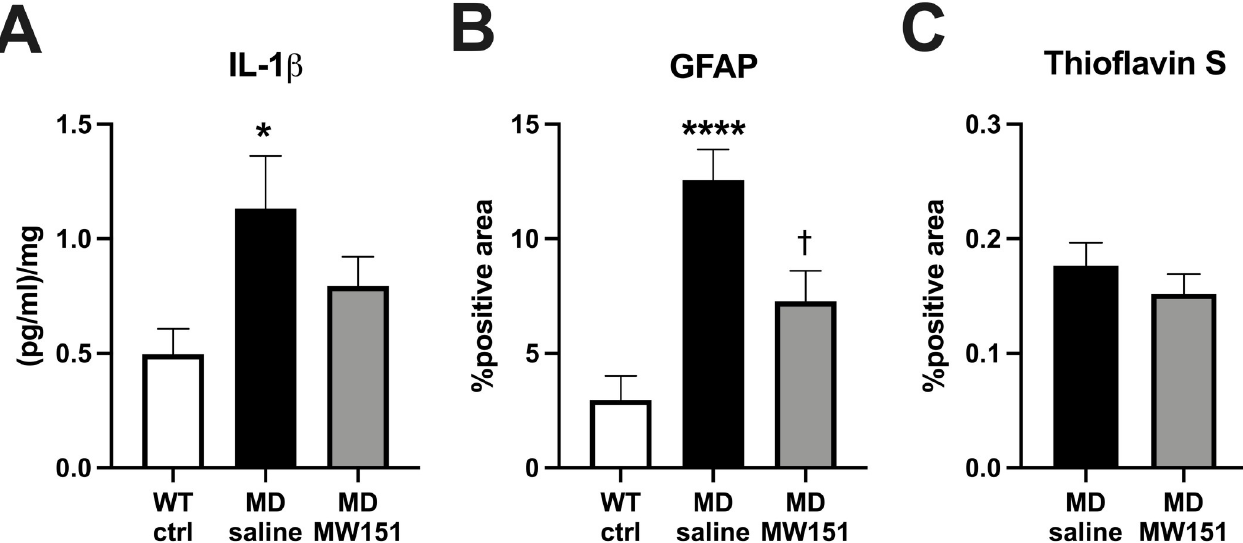
Fig 5. MW151 treatment reduces hippocampal IL-1 β and GFAP elevations in the MD mice, with no effect on Thioflavin S positive amyloid plaque burden. ( A ) MD saline mice (n = 12) had significantly greater IL-1 β levels in the hippocampus versus WT ctrl (n = 13), an effect not observed in the MD MW151 mice. One-way ANOVA (F(2, 36) = 3.822, p = 0.0312), � p < .05 versus WT ctrl, Holm-Sidak post hoc. ( B ) Hippocampal GFAP positivity is increased in the MD saline mice (n = 10) versus WT ctrl (n = 12), but not MD MW151 mice (n = 10). One-way ANOVA (F(2, 29) = 15.66, p < .0001), ���� p < .0001 versus WT ctrl, †p < .05 versus MD saline, Holm-Sidak post hocs. (C) No differences were seen in amyloid plaque burden, as assessed by Thioflavin S staining, between MD saline and MD MW151 mice.